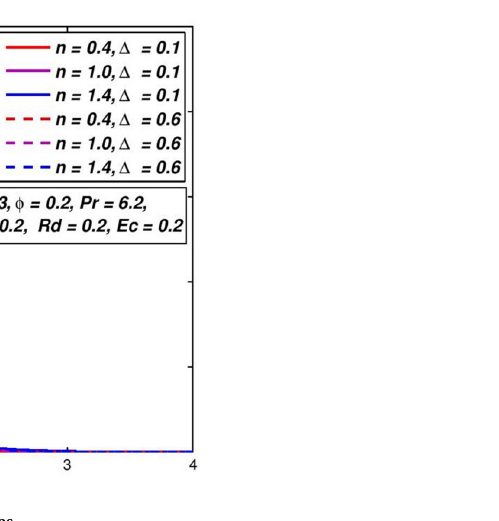
Fig 19. Effect of Δ on θ ( η ) for diverse n